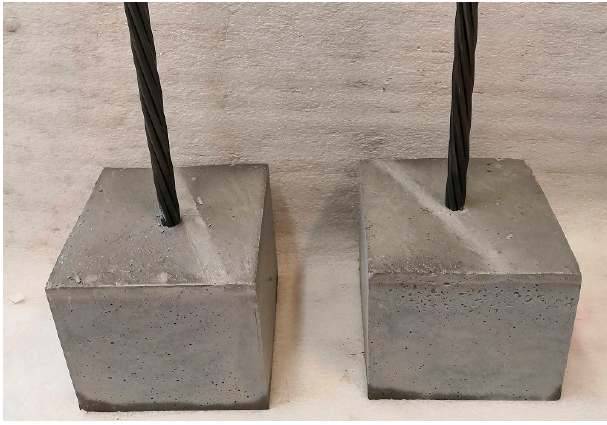
Figure 5. Overview of two UHPC samples for bond strength tests.